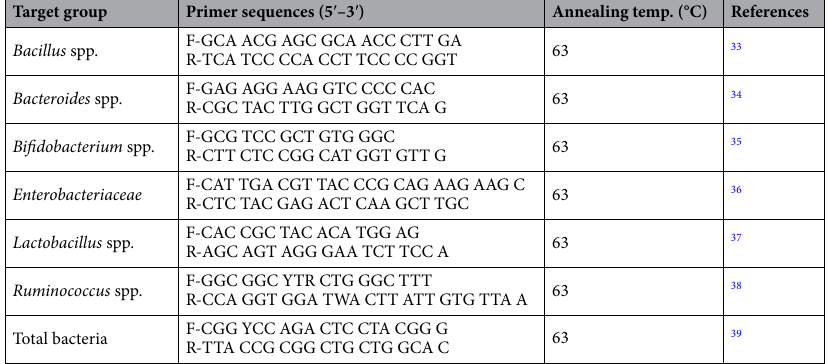
Table 2. Primers sequences use for the qPCR analysis of selected bacteria